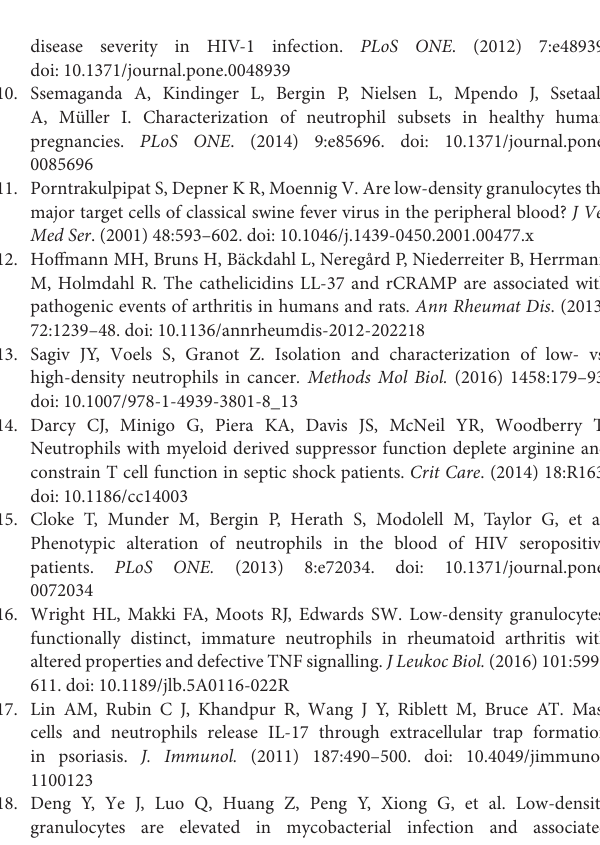
Supplementary Figure 1 | Schematic Diagram depicting the difference between Standard, modified Percoll, and lymphoprep isolations. LDGs co-localize with PBMC layer at a density of <1.077 g/ml during density gradient preparations. Schematic representation of PBMC/LDG, neutrophil and RBC isolation from whole blood using three density (55, 65, and 85%) standard Percoll method (A) . PBMC/LDG and neutrophil isolation using two density (55 and 65%) modified Percoll density gradient separation (B) and PBMC/LDG and neutrophil isolation using 2 density Lymphoprep density gradient separation. Supplementary Figure 2 | CD16- LDG from patients with active AAV lack surface expression of the autoantigen MPO. Surface expression of MPO on CD16 subsets of LDG were analyzed for healthy control (n = 5) (A) , disease control ( n = 5) (B) and AAV patients ( n = 10) (C) . MPO surface expression was increased on CD16 + LDG in AAV patients, compared to healthy and disease control. Although, no differences were observed in MPO expression within CD16 subsets in healthy and disease controls, CD16 − LDG from AAV patients had very low MPO expression compared to CD16 + and CD16 int , groups were compared using repeated-measures one-way ANOVA, ∗ p < 0.05. Supplementary Figure 3 | CD16 and CD10, but not LOX-1, have a bimodal distribution in LDG. Histogram overlays of CD15 + SSC hi CD14 − singlets in LDG (dark gray) and NDG (light gray) preparations are displayed from a representative acute AAV patient sample showing surface expression of CD16 (A) , CD10 (B) , and LOX-1 (C) . Supplementary Table 1 | Panel of antibodies used in flow cytometry experiments. Supplementary Table 2 | Panel of antibodies used in G-CSF treated mice flow cytometric